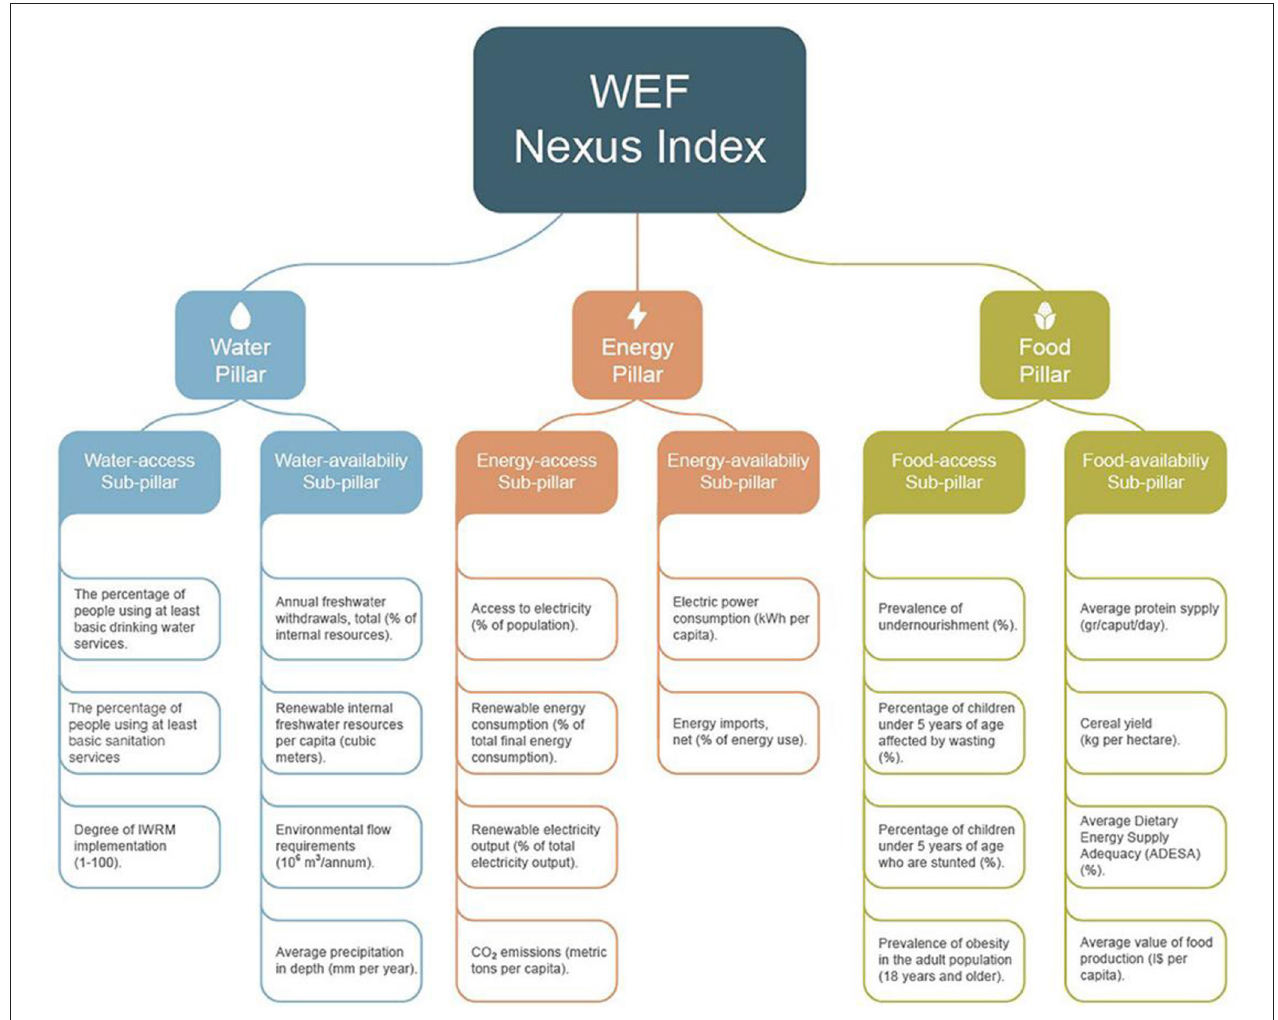
FIGURE 1 | The composition of the WEF Nexus Index. From Simpson et al. (this Research